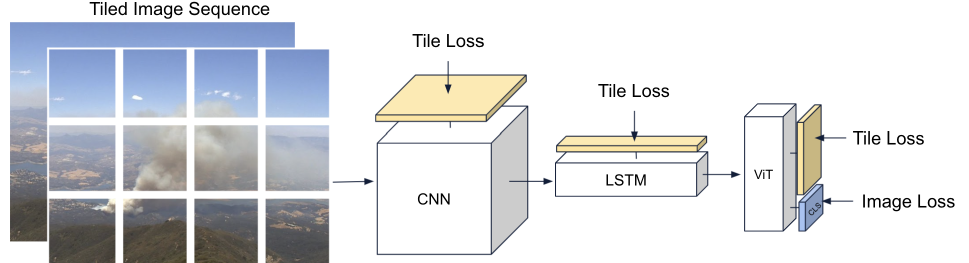
Figure 2. The SmokeyNet architecture takes two frames of the tiled image sequence as input and combines a CNN, LSTM, and ViT. The yellow blocks denote “tile heads” used for intermediate supervision, while the blue block denotes the “image head” used for the final image